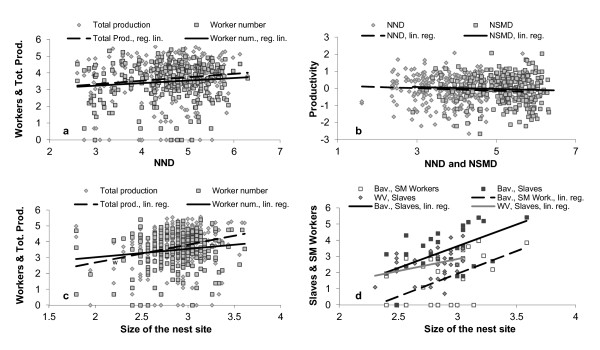
The influence of competition and nest site size on various life-history variables. (a) The correlation of distance to nearest conspecific colony with number of workers (squares, continuous line) and total production (diamonds, dashed line) in the Bavarian community. (b) The correlation of distance to nearest conspecific (diamonds, dashed line) and slavemaking colony (squares, continuous line) with colony per-capita productivity in the NY community. (c) The correlation of size of the nest site with workers (squares, continuous line) and total production (diamonds, dashed line) in the Bavarian community. (d) The correlation of nest site size with number of slaves (black squares, continuous line) and slavemaking workers (white squares, dashed line) in the Bavarian community, and of nest site size with number of slaves (grey diamonds, grey line) in the WV community. All variables are log transformed.